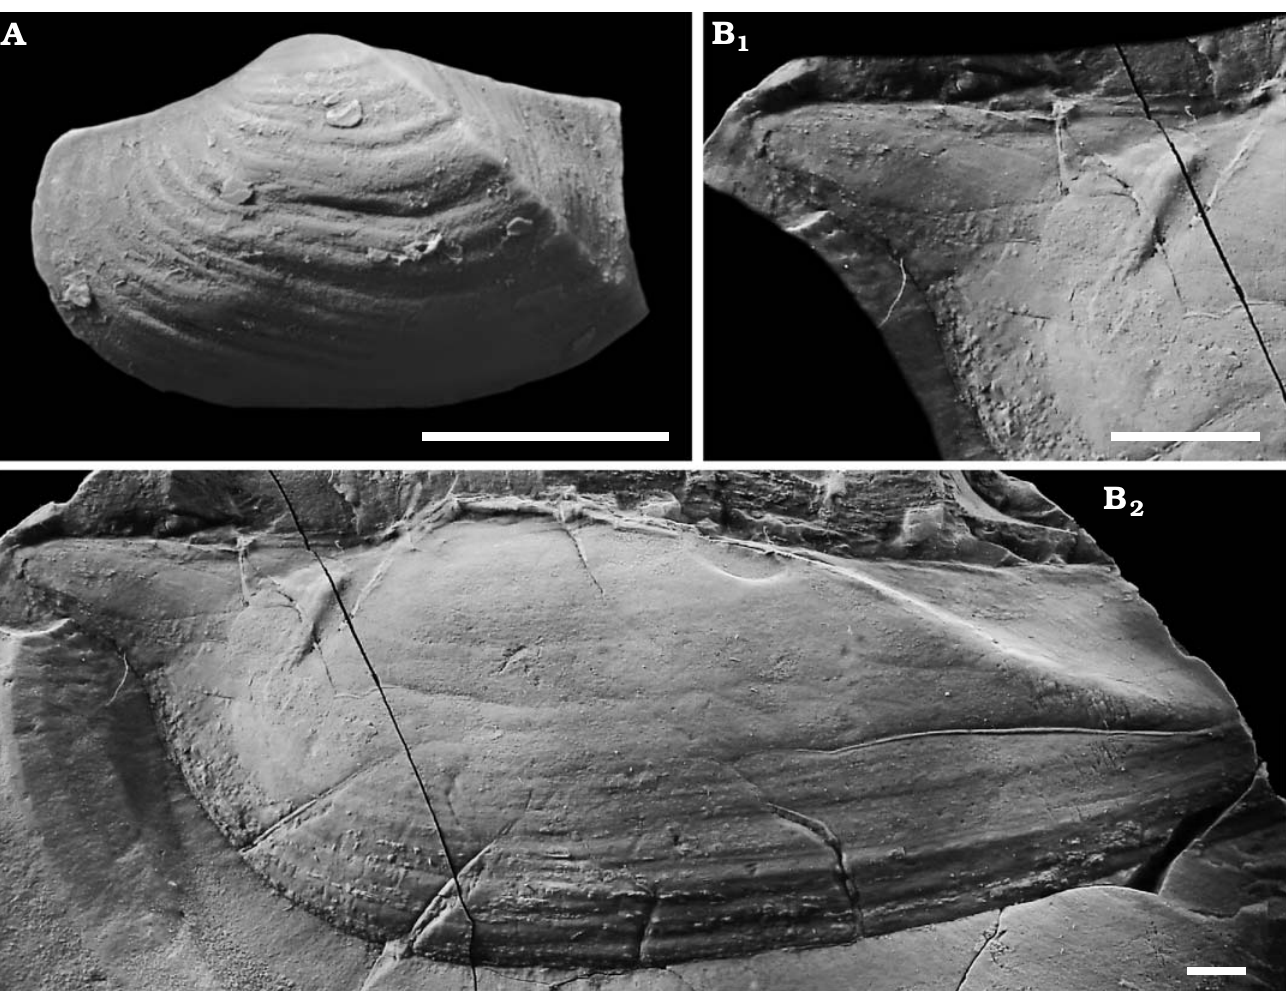
Fig. 7. Pachydomid bivalves from the Guadalupian (Permian), Teresina and Serra Alta formations, respectively, Paraná Basin, Brazil. A . Holdhausiella elongata (Holdhaus, 1918), DZP-20441, silicified shell, left valve, note the pointed anterior margin of the shell. B . Anhembia gigantea (Mendes, 1949), DGP/7-91, composite mold, left valve; B 1 , detail of a well-developed rostrum, B 2 , general view. Scale bars 5